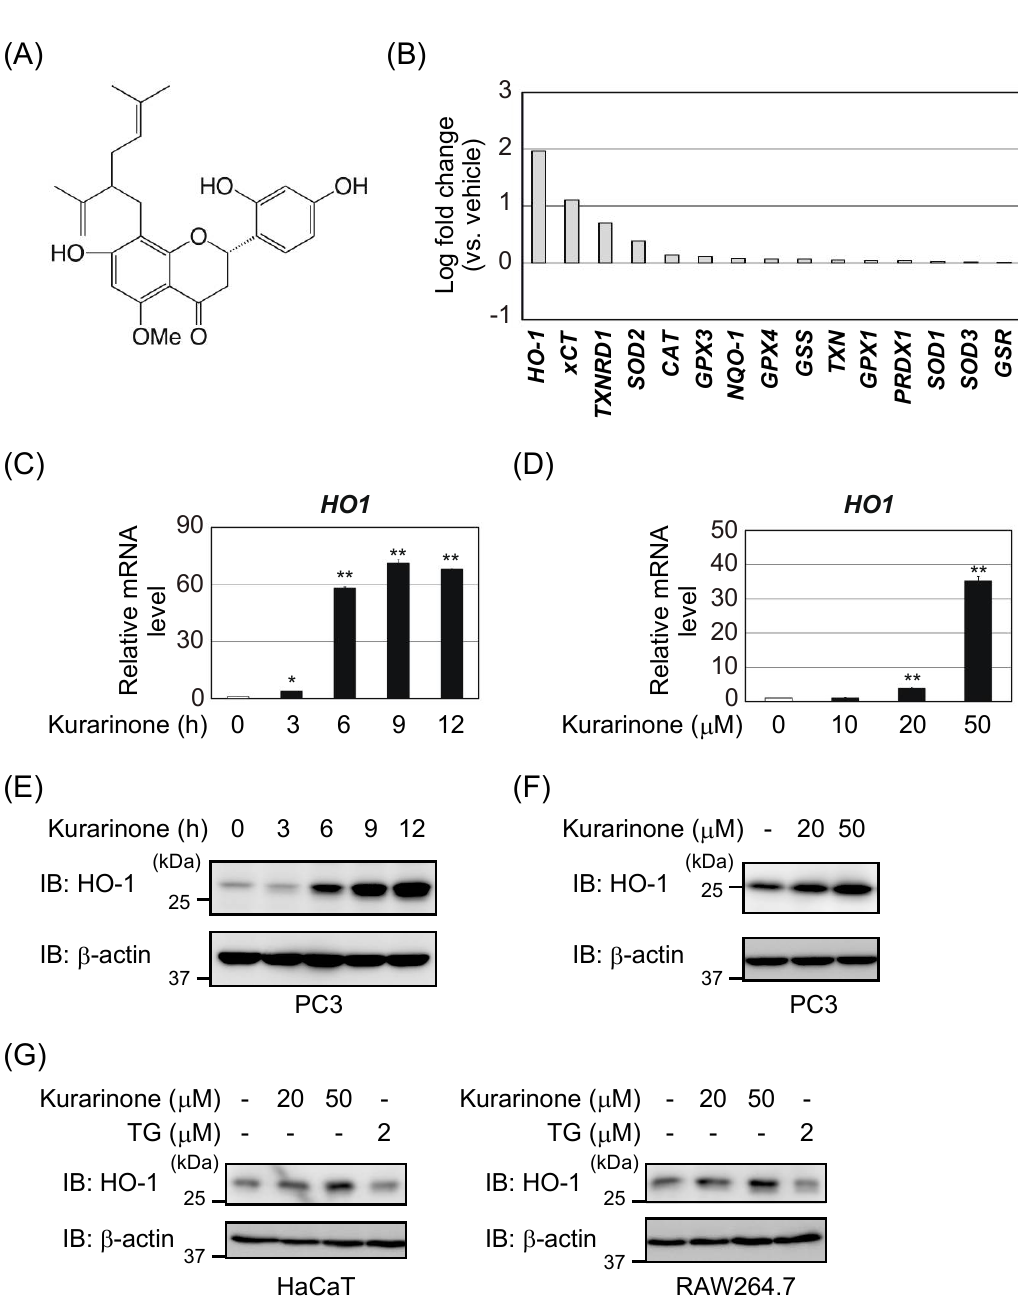
Figure 1. Kurarinone induces several antioxidant enzymes, including HO-1. ( A ) Structure of kurarinone. ( B ) PC3 cells were treated with 50 μM kurarinone for 6 h. The expression of each gene was assessed by quantitative PCR (qPCR). The experiment was performed in duplicates. Results show fold changes from the DMSO-treated control group. ( C , E ) PC3 cells were treated with 50 μM kurarinone for the indicated periods. (C) HO-1 mRNA expression levels were assessed by qPCR. Results were shown as the mean ± S.D. ( n = 3). ( E ) Cell lysates were immunoblotted with the indicated antibodies. ( D , F ) PC3 cells were treated with the indicated doses of kurarinone for 6 h. (D) HO-1 mRNA expression levels were assessed by qPCR, as in ( C ). ( F ) Cell lysates were immunoblotted with the indicated antibodies, as in ( E ). ( G ) RAW264.7 and HaCaT cells were treated with the indicated doses of kurarinone or 2 µ M thapsigargin (TG) for 6 h. Cell lysates were immunoblotted with the indicated antibodies, as in ( E ). Significant differences were indicated as ** p < 0.01, * p <0.05 vs. the group without kurarinone-treatment.